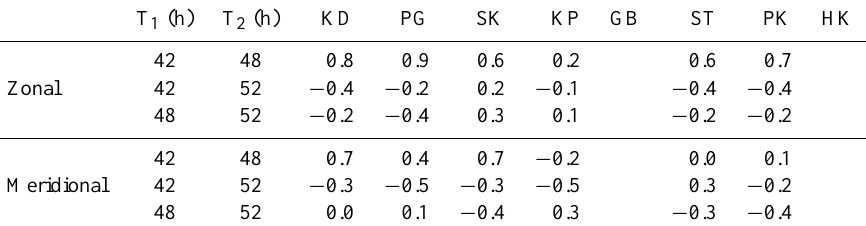
Table 2. The correlation coefficients of the normalised power spectrum of the 42-, 48- and 52-h for the summer duration, for the zonal and the meridional components.